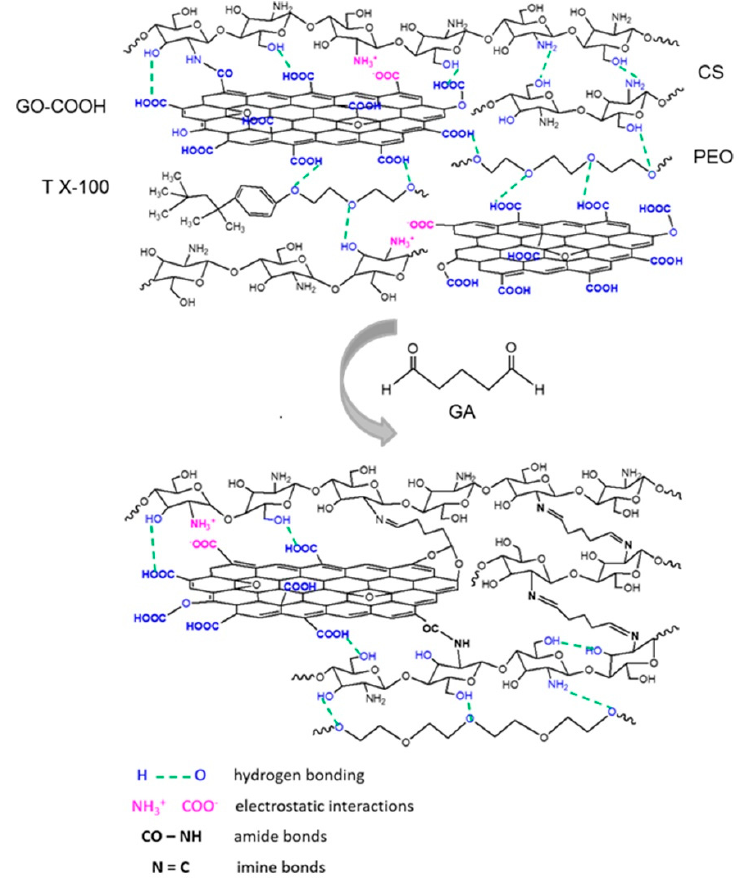
Figure 1. Schematic representation of different types of interactions that can take place between the functionalities of the structures used in the design of composite scaffolds with nanofibrous architecture. Abbreviations: GO-COOH—carboxylated graphene oxide; CS—chitosan; T X-100—Triton X-100; PEO—poly(ethylene oxide); GA—glutaraldehyde.